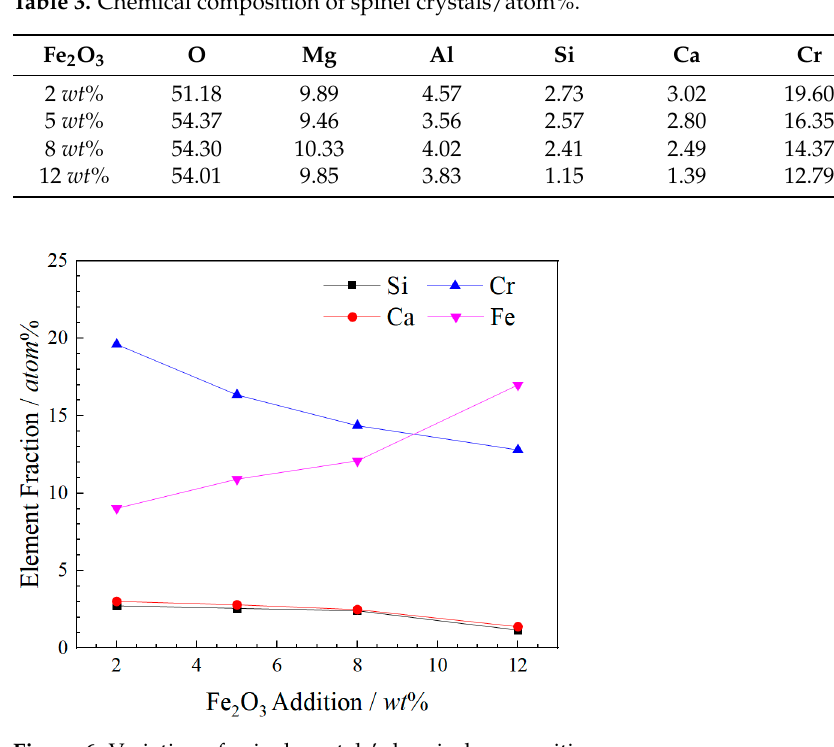
Table 3. Chemical composition of spinel crystals/atom%.